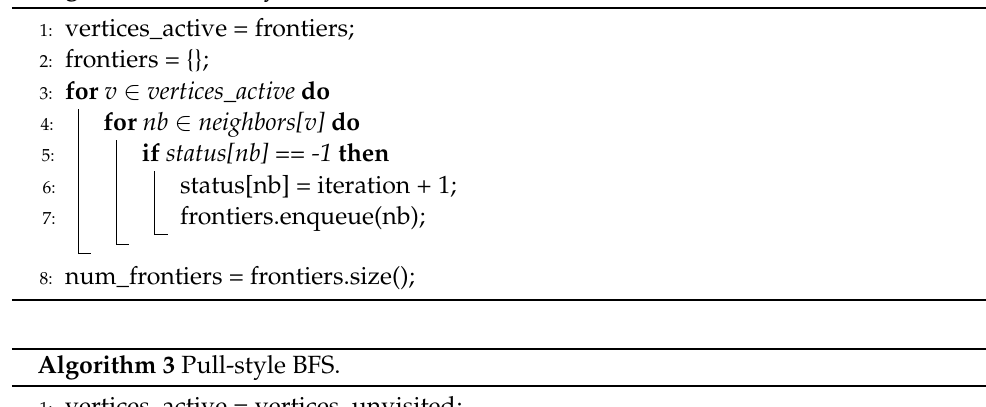
Algorithm 2 Push-style BFS.